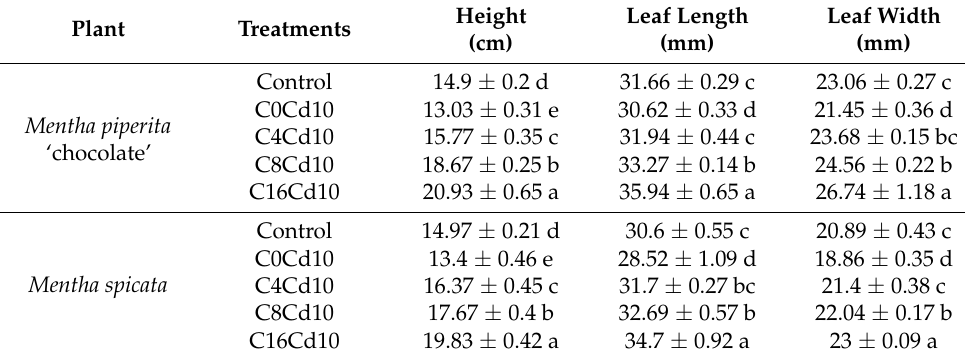
Table 3. Effect of biochar on the growth of two mint species under Cd